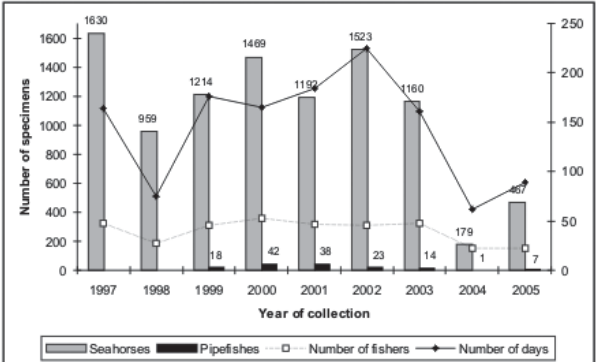
Fig. 6. Number of fishers and of syngnathids captured for ornamental purposes in Salvador, Bahia, Brazil, from January/ 1997 to